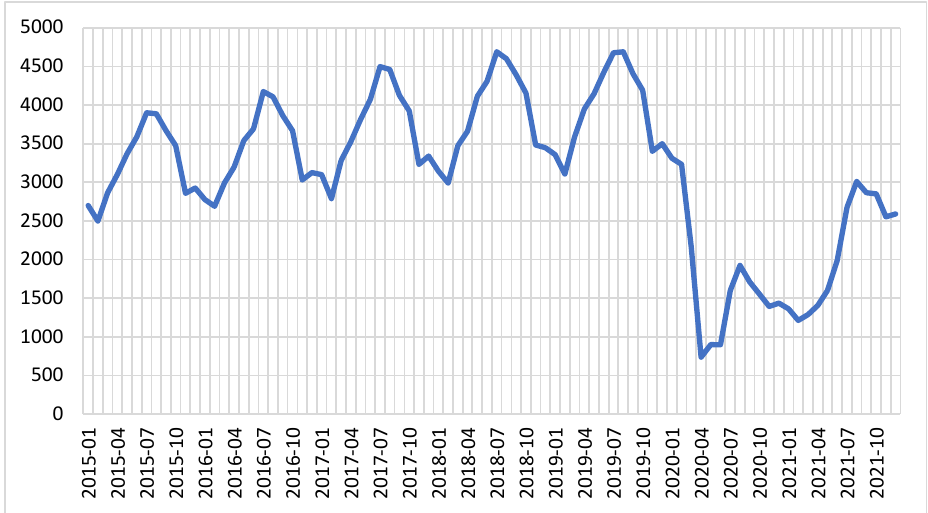
Figure 1. The evolution of the volume of kerosene-type jet fuel supplies to EU countries (in thousand tonnes). Source: own elaboration.